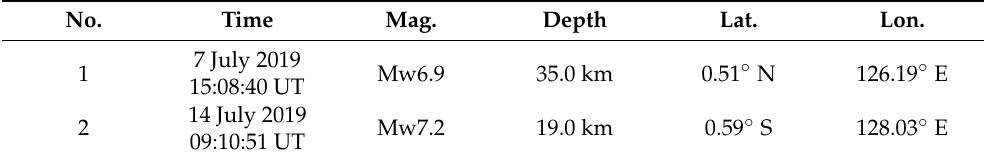
Table 1. The information of two earthquakes. No.